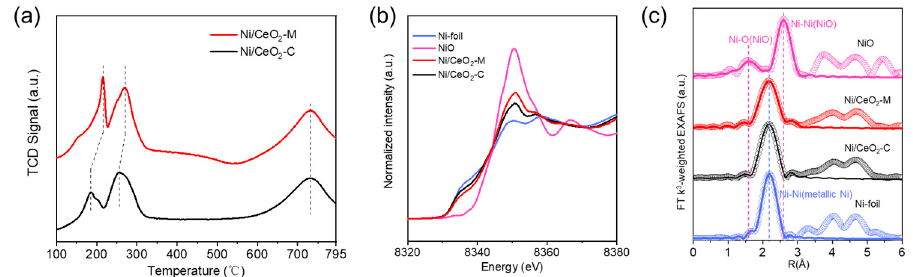
Figure 7. ( a ) TPR profile; ( b ) XANES and ( c ) EXAFS of spent Ni/CeO 2 -C and spent Ni/CeO 2 -M catalysts.